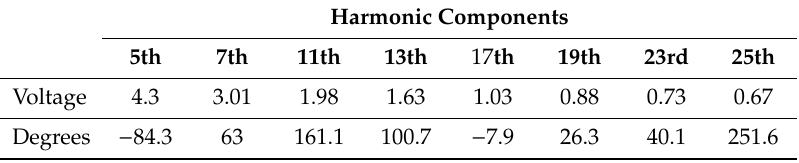
Table 4. Harmonic components of the rotor voltage for test case 1.